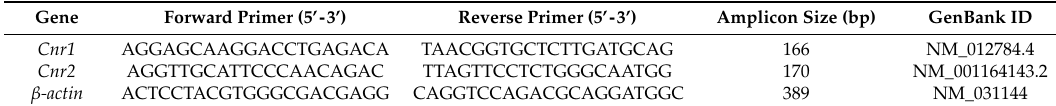
Table 1. Rat primer and